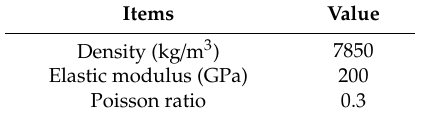
Figure 5. The model and mesh division of the propeller (Left: blade face; Right: blade back). Table 1. The material parameters of the propeller.